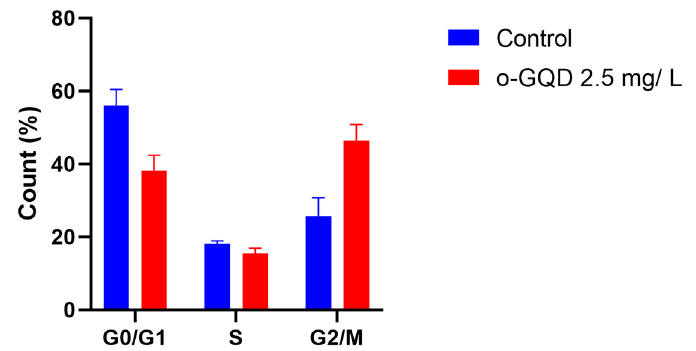
Figure 6. Percentage of cells in each cell cycle phase in MCF-7 cells with/without o-GQD (2.5 mg/L) treatment. The data indicate averages from triplicates, and the error bars indicate SD.